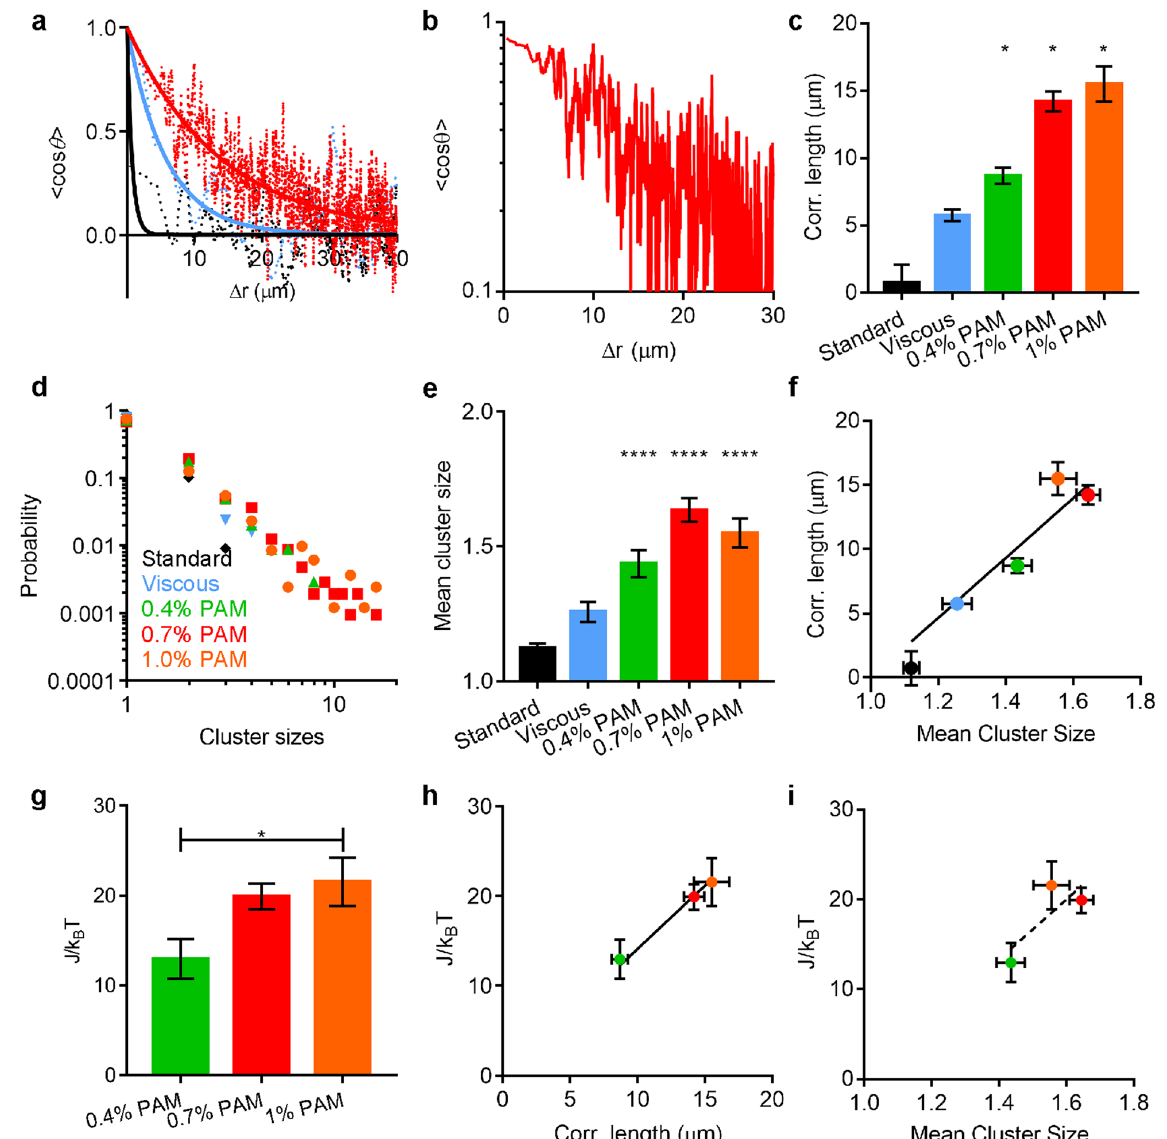
Figure 2. Sperm orientation correlation length and cluster size increase with fluid elasticity. ( a ) The spatial correlation of sperm head orientation as a function of distance in standard medium (black lines), viscous 3% PVP (blue lines) and viscoelastic 0.7% PAM (red lines). Dashed lines are smoothed experimental data and solid lines are fitted data. ( b ) Spatial orientation correlation function exhibits an exponential decay. ( c ) Correlation lengths of sperm in different media. * p < 0.05 from non-overlapping 95% confidence levels, compared with standard medium. ( d ) Distributions of sperm cluster size in different media in log-log scale. 1 = single cell. Cluster size distributions follow a power-law function. ( e ) Mean cluster sizes of sperm in different media. **** p < 0.0001, compared to standard medium, from one-way ANOVA. ( f ) Mean correlation length plotted against mean cluster size. Linear regression shows a line with a slope that is significantly non-zero (p < 0.0001), and intersects the x axis at x = 1.0. Data derived from analyses of 5392 cells. Pearson r = 0.97. ( g ) Alignment coupling strength in different concentration of PAM solutions. * p < 0.05 from one-way ANOVA; s.e.m. are plotted, N = 10. ( h ) Coupling strengths and correlation lengths are highly correlated. Spearman r = 1 and p = 0.015. ( i ) Coupling strengths and average cluster sizes are less correlated with Spearman r = 0.81 and p =